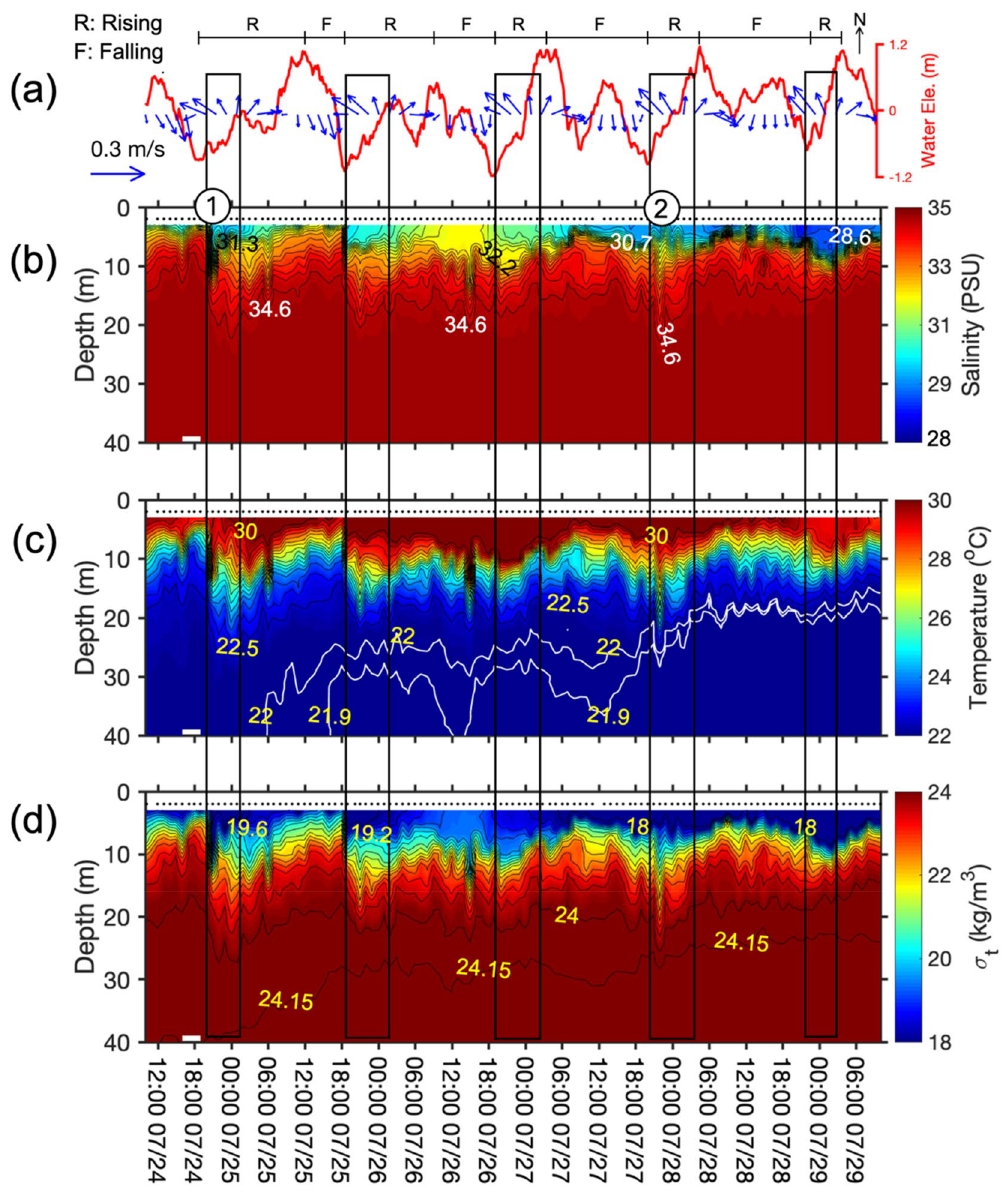
Figure 3. ADCP and shipboard measurements at ZHJ2. ( a ) stick diagram of mean tidal current averaged over the top 5 m superimposed with the sea-surface fluctuations (red line) recorded by ADCP. Text "R" and "F" above the sea-surface fluctuations indicate the period from lower low-water to higher highwater (rising tide) and from higher highwater to lower low-water (falling tide), respectively. CTD profiling measurements of ( b ) salinity, ( c ) temperature, and ( d ) density are contoured, respectively. The white lines in (c) indicate 21.9 °C and 22 °C isotherms. The black dots above the CTD data denote times of profiling. The periods with onshore current are marked with the black rectangles. Circled numbers "1" and "2" indicate the examples of the NIWs described in the text and in following